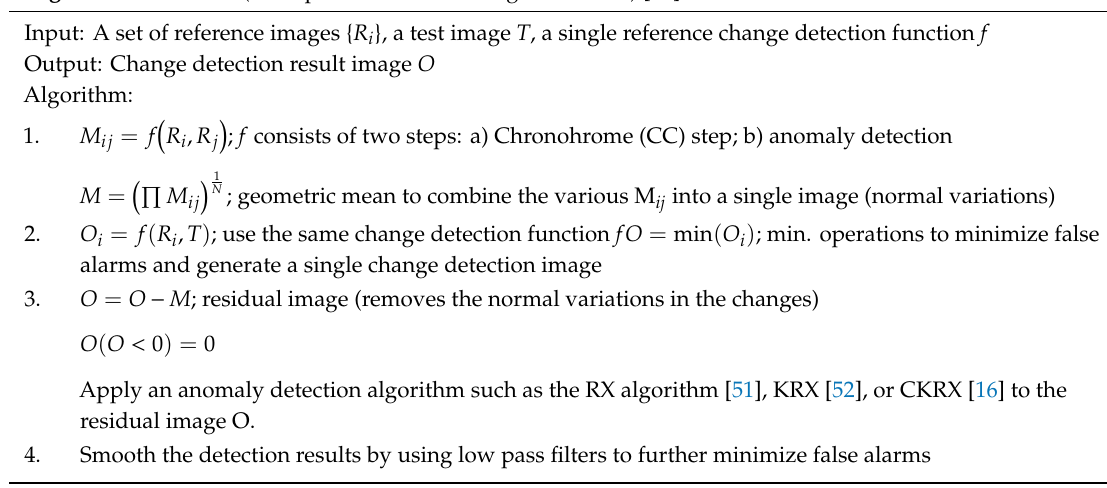
Algorithm 1. MRCD: (Multiple References Change Detection) [55]